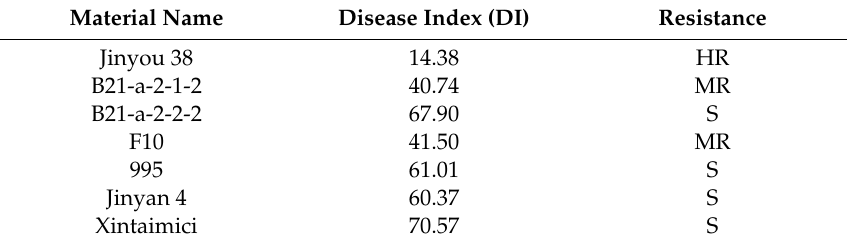
Table 1. The disease index of di ff erent cucumber cultivars to